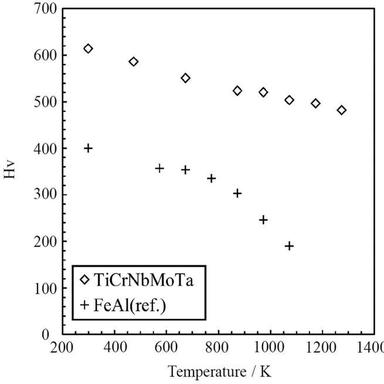
Vickers hardness of a sintered TiCrNbMoTa specimen as a function of temperature.